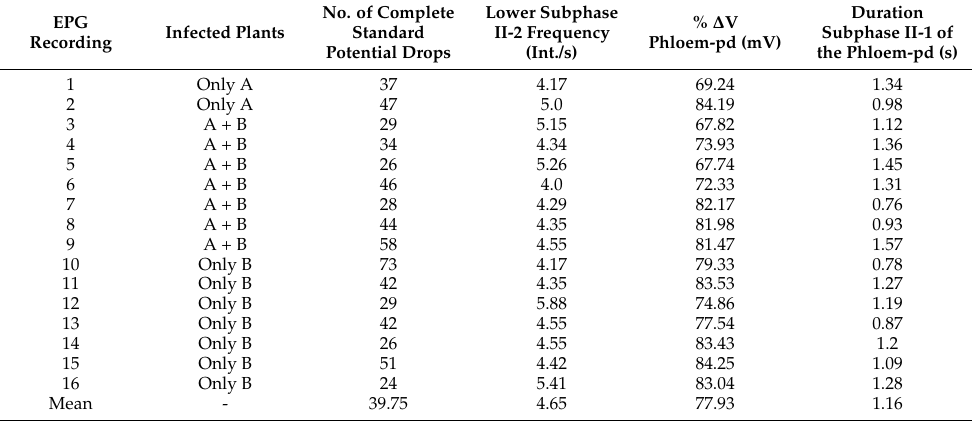
Table 2. EPG recordings interrupted during the subphase II-1 of the phloem-pd. EPG recording were thoroughly inspected in order to discard the occurrence of a previous phloem-pd. Plants infected during EPG recording for each EPG recording are expressed. The total number of potential drops produced by the aphid along the recording as well as minimum frequency of intervals observed in a subphase II-2 are indicated. Moreover, percentage of potential drop magnitude of the phloem-pd in comparison with the previous standard-pd was measured in order to determine the production of the phloem-pd. Duration of each interrupted subphase II-1 was measured. No. of Complete Lower Subphase EPG Standard II-2 Frequency Recording Infected Plants Potential Drops